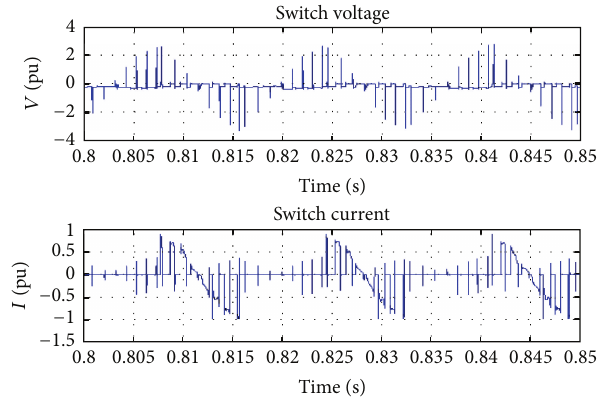
Figure 13: Switching of voltage and current.